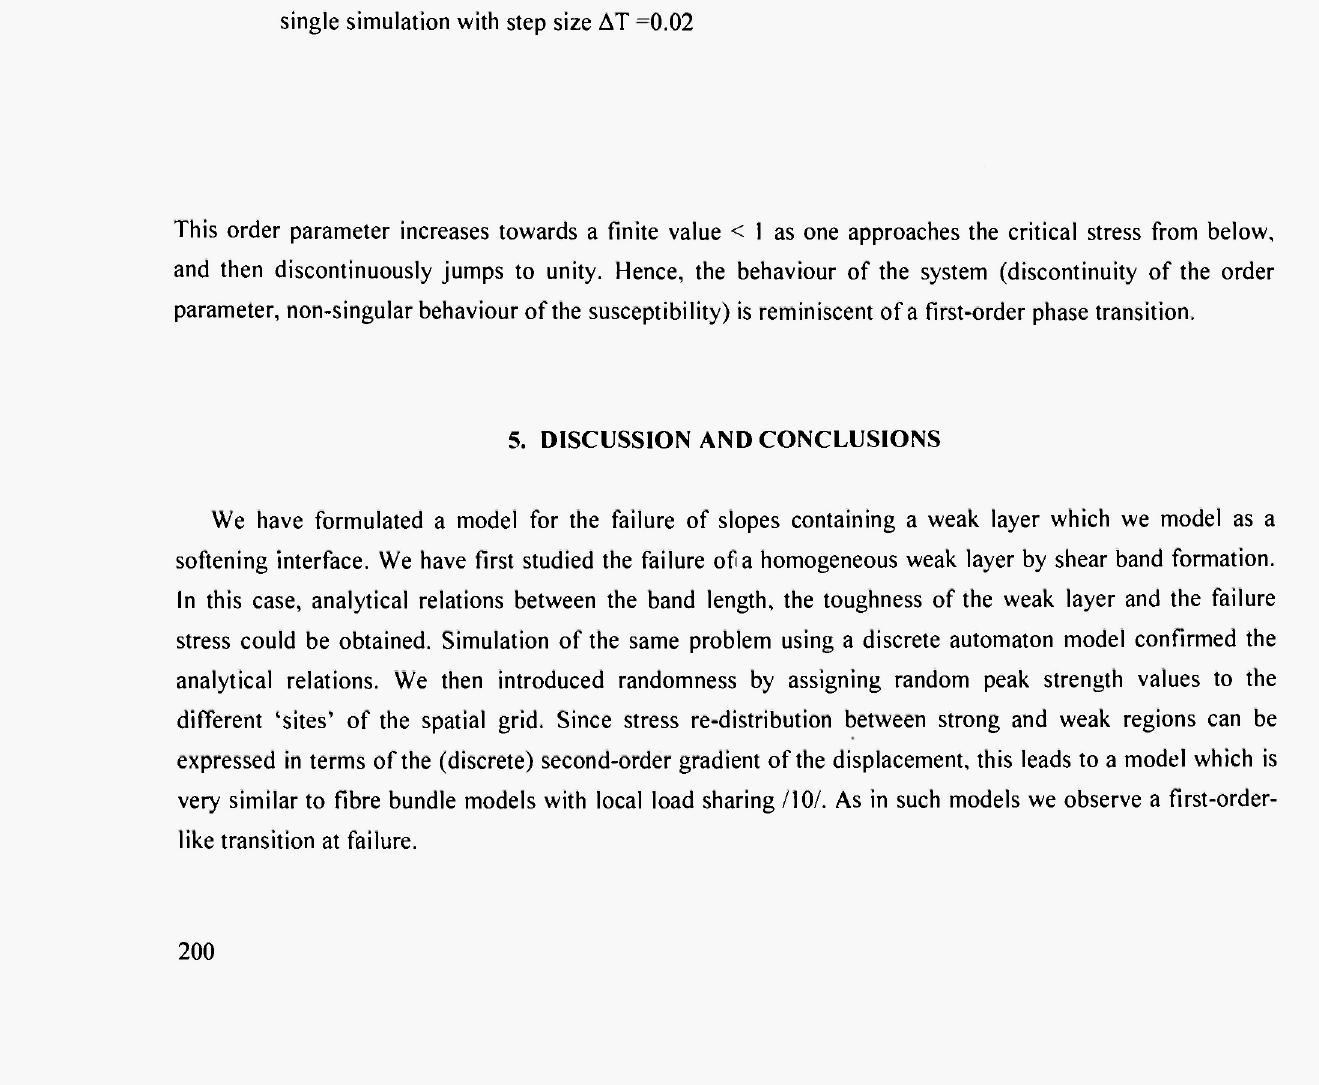
Fig. 11: Average slope susceptibility (mean displacement increment per unit stress increment, average over I0 4 simulations) as a function of distance from critical stress. Insert: displacement increments in a single simulation with step size ΔΤ